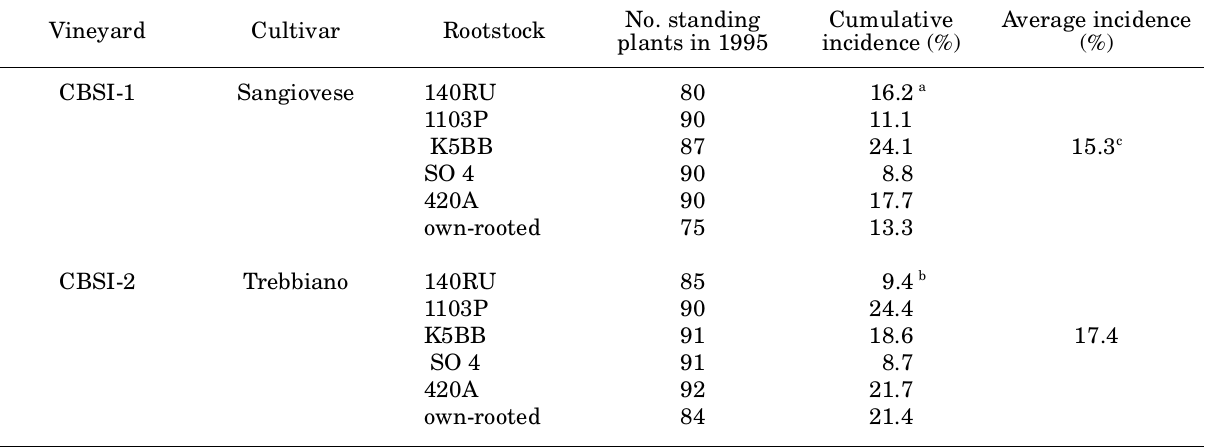
Table 2. Cumulative esca incidence in a vineyard planted with the cv. Sangiovese (CBSI-1) and Trebbiano (CBSI-2), on five different rootstocks and own-rooted. The incidence is the percentage of all plants that exhibited symptoms at least once in the five-year period